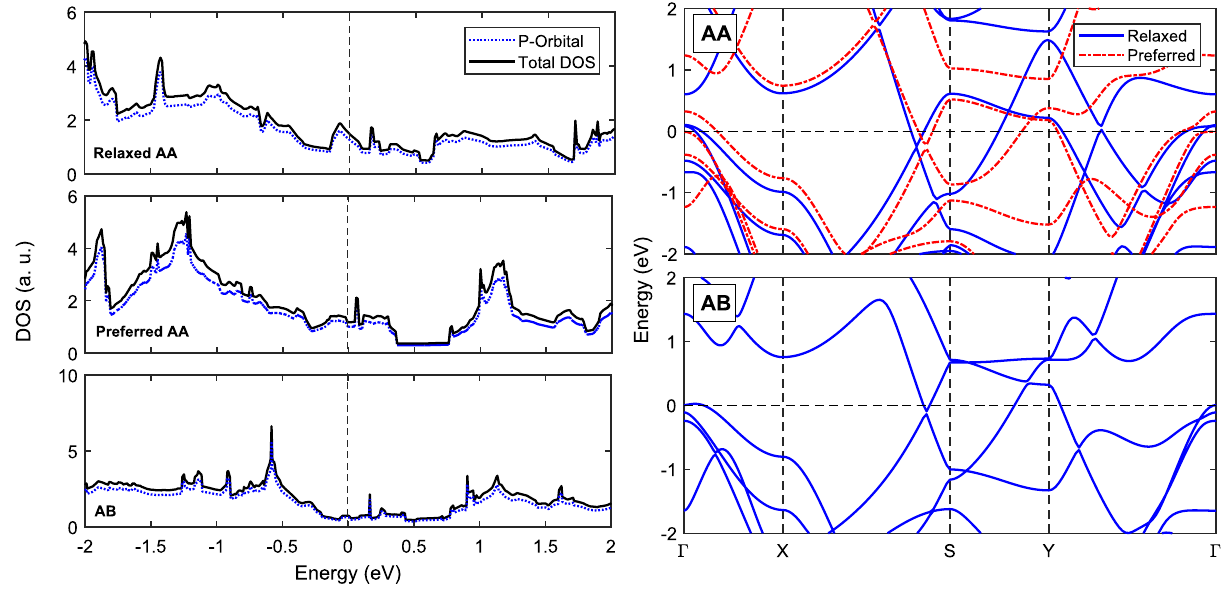
Figure 6. Density of states (DOS) and band structures of the AA and AB stacked β 12 bilayer borophene models.